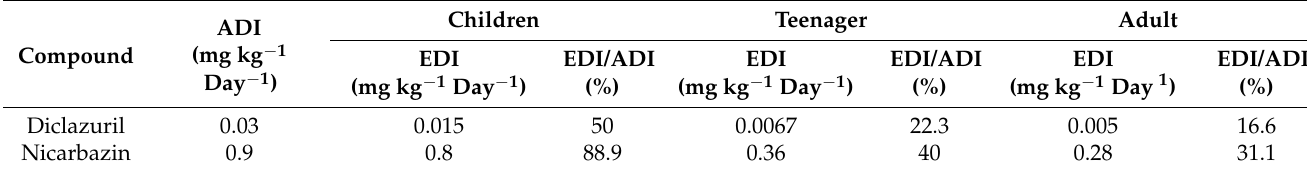
Table 6. Comparison of ADI and EDI (mg kg − 1 day − 1 ), using the highest detected concentrations (i.e., worst-case scenario), for the children, teenagers, and adult